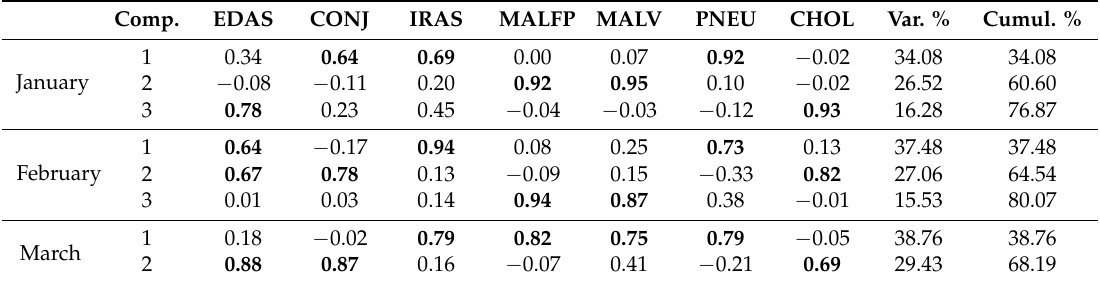
Table 4. Principal component analysis output for the ecosyndemic index by